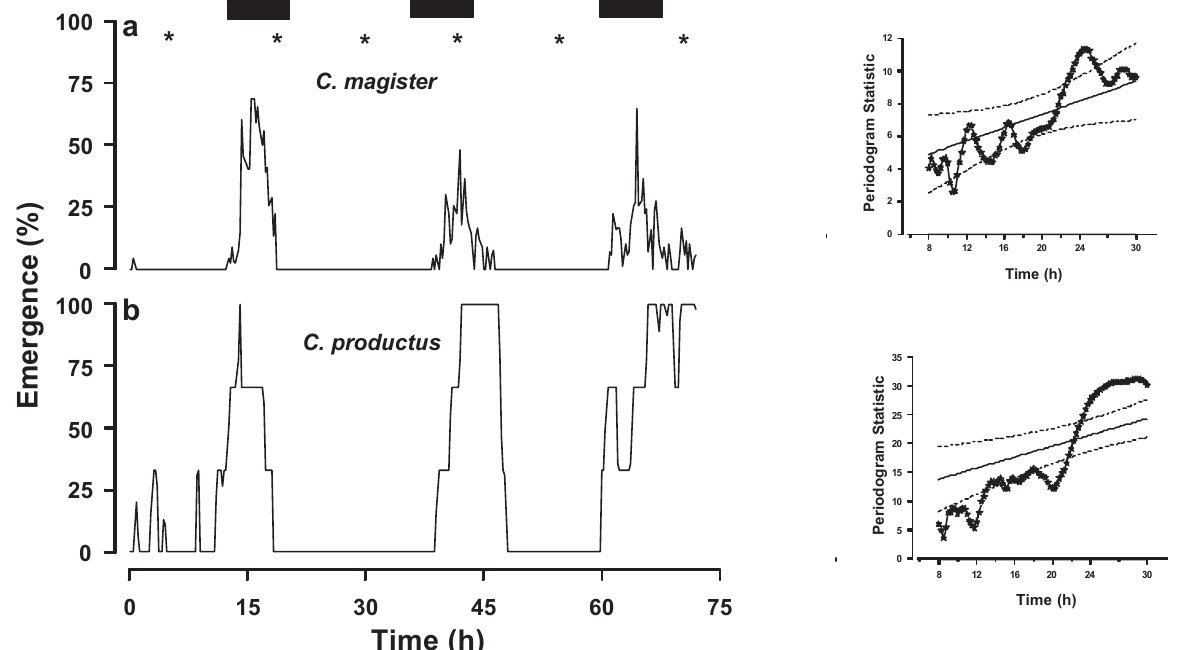
F IG . 2. – Percentage activity (per 15 min interval, with no averaging between intervals) of a) Cancer magister and b) Cancer productus (n=4 of each species) freshly collected from Sarita Bay when high tide predominated during the hours of darkness and recorded for 3 days in constant dim red light. Bars represent times of expected darkness and asterixes represent times of expected high tide in the field. Periodogram statistics are shown for each species on the right side of the graph. The periodogram graph represents data from periodic regression. The X axis is the period time in hours and the Y axis is the amplitude of the rhythm. Deviation outside 95% confidence limits (dashed lines) is